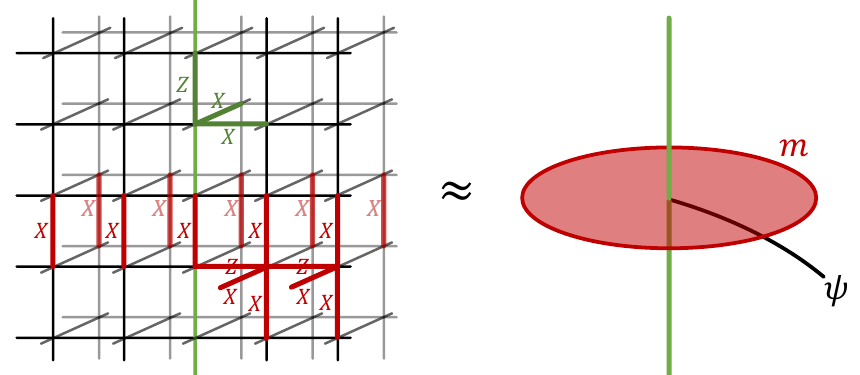
Figure 17: The membrane operator which commutes will all terms in its bulk. This operator can be thought of as the ψ -line coming out from the intersection of the twist string and the membrane operator of the m -loop excitation.